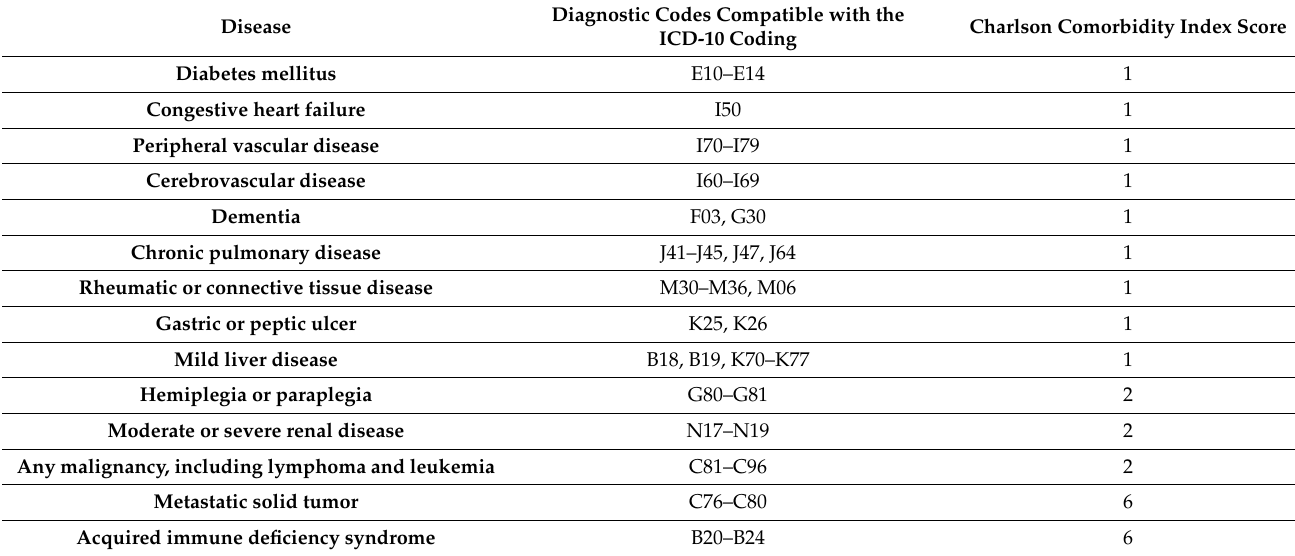
Table 1. Disease list used for calculating the Charlson Comorbidity Index.